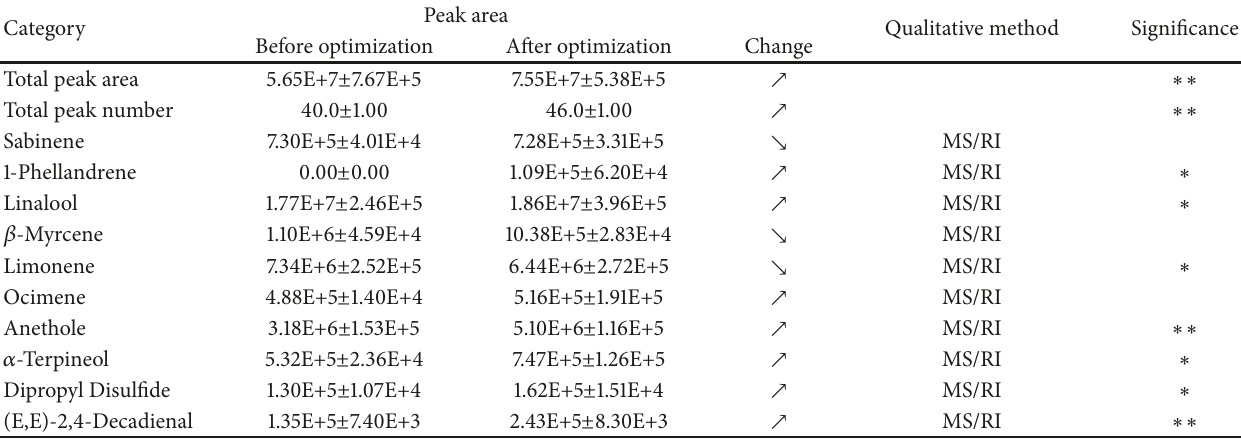
Table 2: Comparison of extraction effect before and after